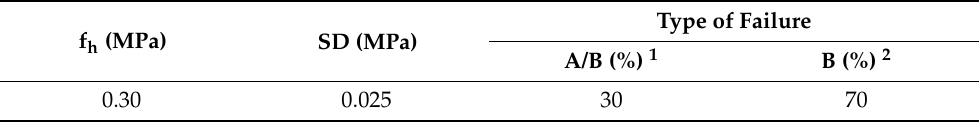
Table 3. Tensile bond strength (f h ) values, the respective standard deviation (SD) and the specific type of coatings’